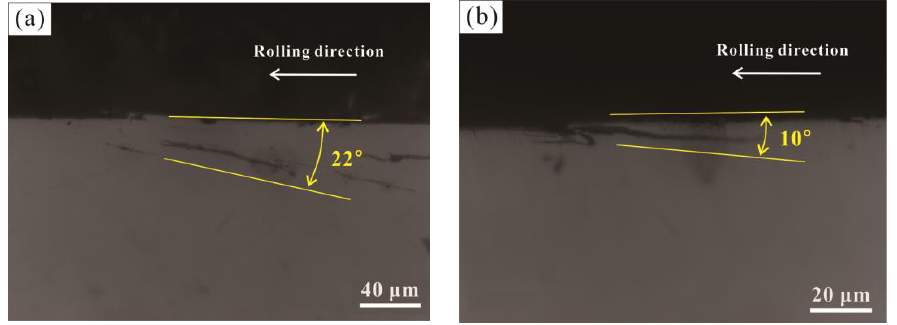
Figure 15. Crack behaviors in wear scar section for the wheel specimen: N = 2 × 10 5 ; ( a ) with gas nitriding group; ( b ) without gas nitriding group.